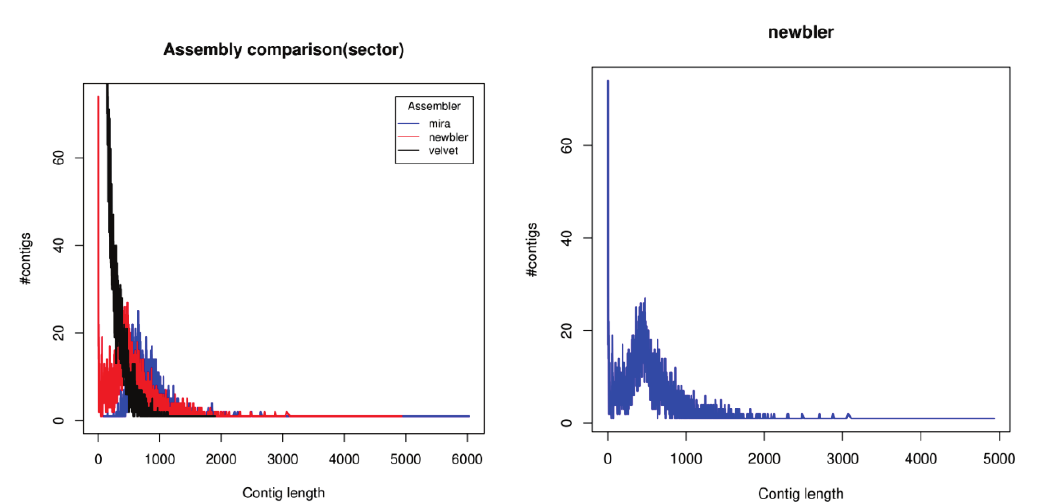
Figure 10: (a) Assembly comparison using the BioPython R component integrated in GITIRBio . (b) Assembly ContigLength using the BioPython R component integrated in GITIRBio.